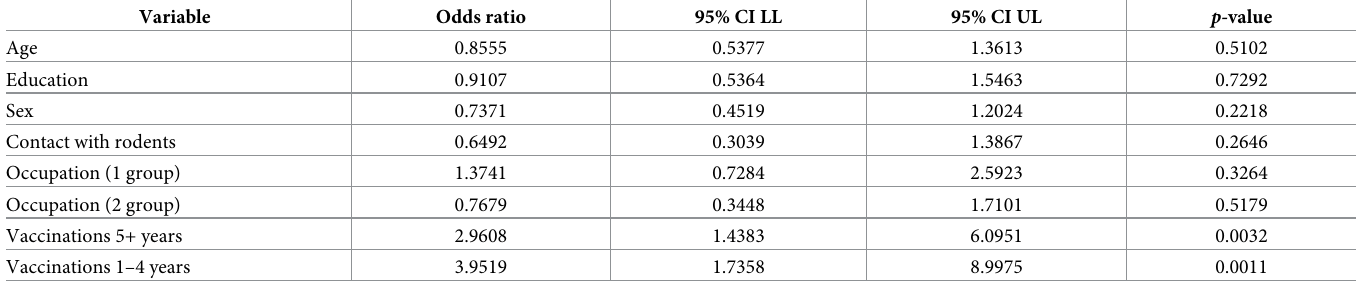
Table 5. Multivariate regression analysis of the relationship between proposed variables and serum antibodies to F1 Y . pestis 4 months after the vaccination.